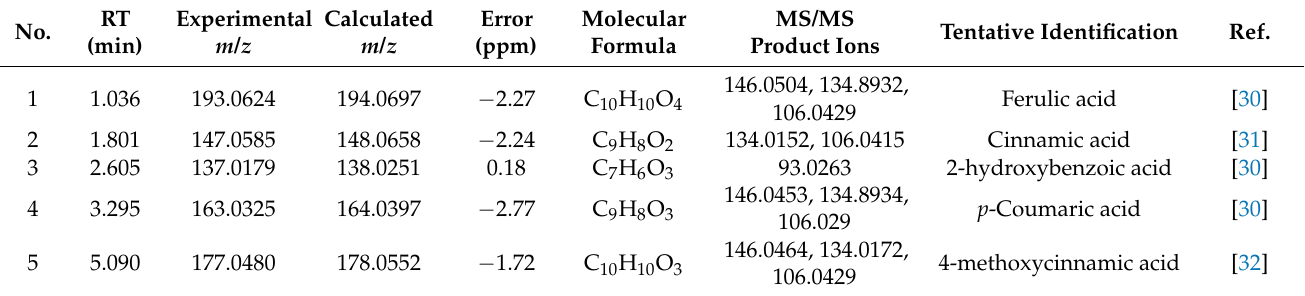
Table 4. List of selected cinnamic acid derivatives tentatively found in BBMR, BBMS, and